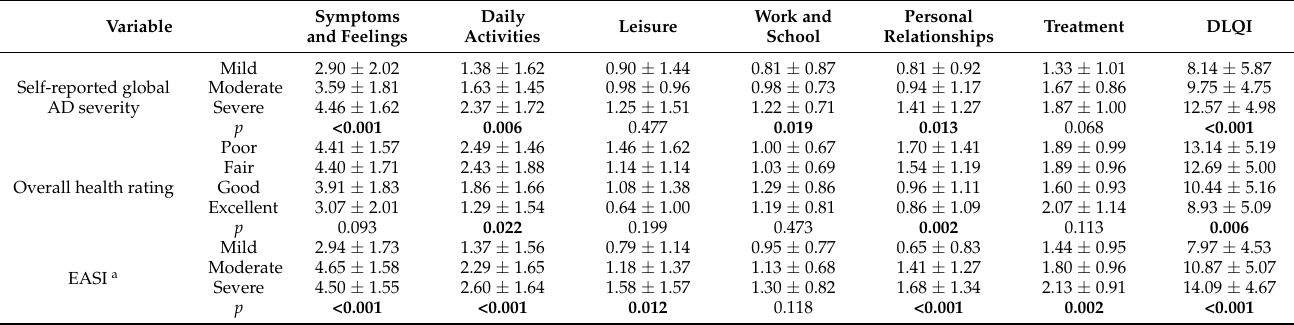
Table 5. Bivariate association between domain-specific, overall DLQI scores and self-perceived AD severity, overall health rating, and the